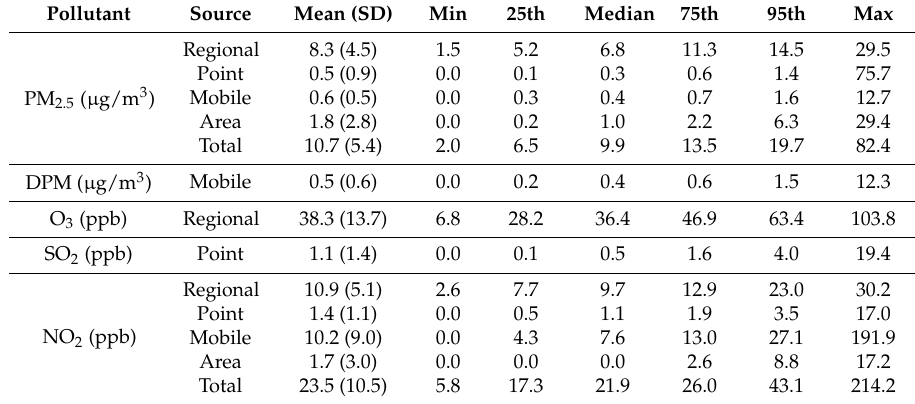
Table 1. Summary statistics of daily concentrations of PM 2.5 and DPM (daily mean, µ g/m 3 ), O 3 (daily 8-h max, ppb), SO 2 (daily mean, ppb), and NO 2 (daily mean, ppb). Contributions from regional, point, mobile, and area sources are separated. Estimated at the census block